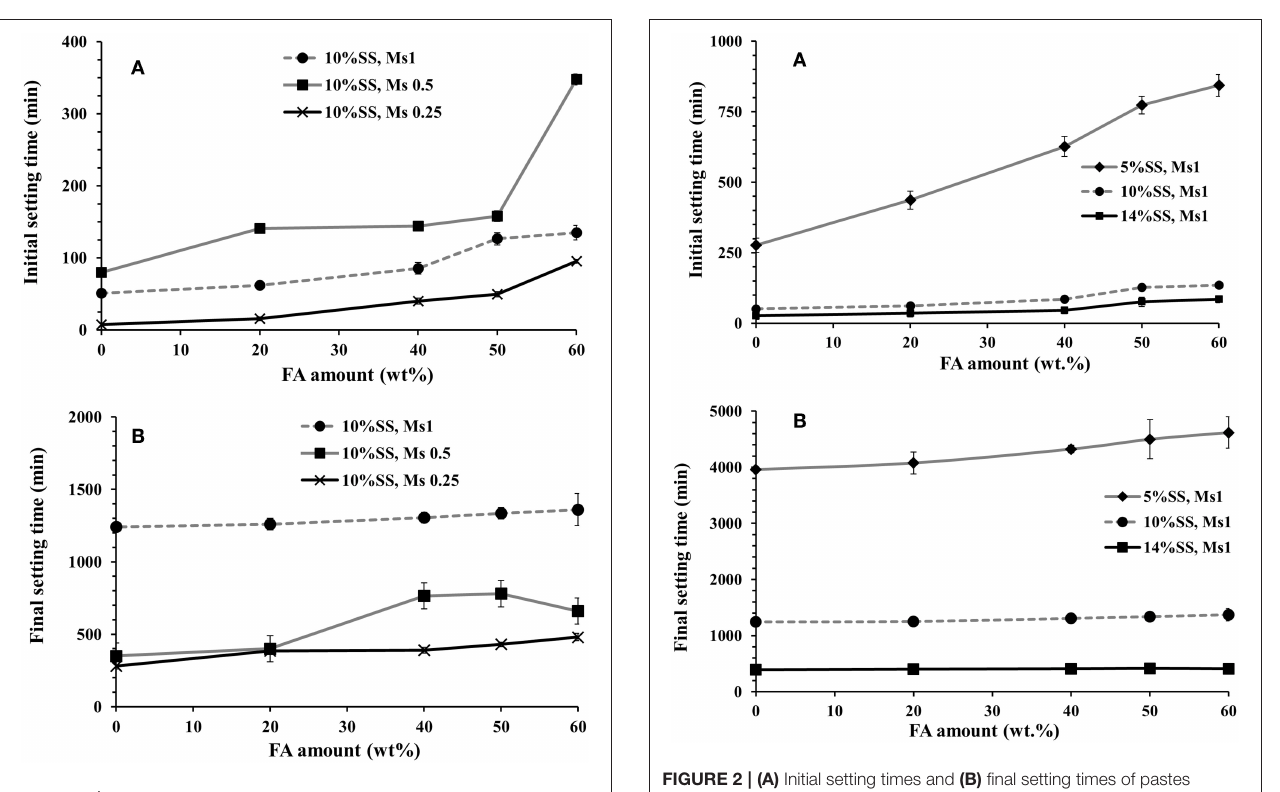
Al and so does not compete with (or act in synergy with) the Ca in removing Si from solution.